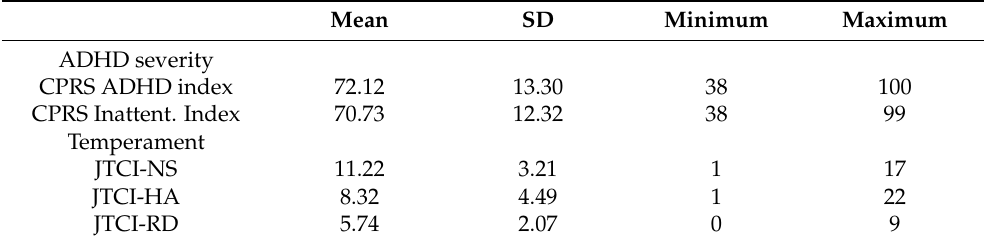
Table 1. Descriptive statistics for all the variables included in the study. Mean SD Minimum